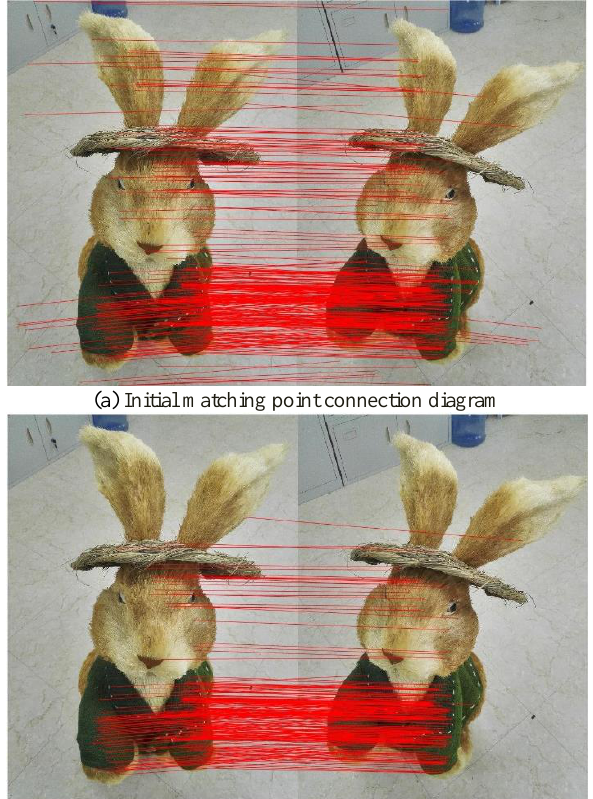
(b) Matching points after RANSAC algorithm processing